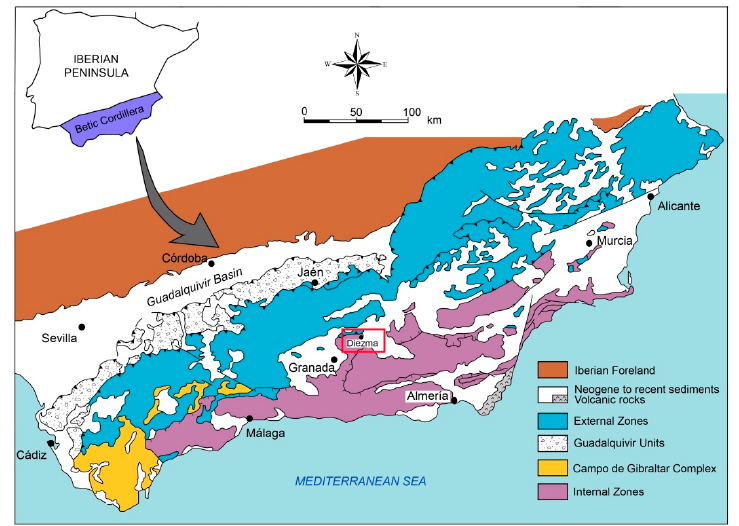
Figure 1. Geological sketch of the Betic Cordillera. The study area is outlined by the red rectangle.